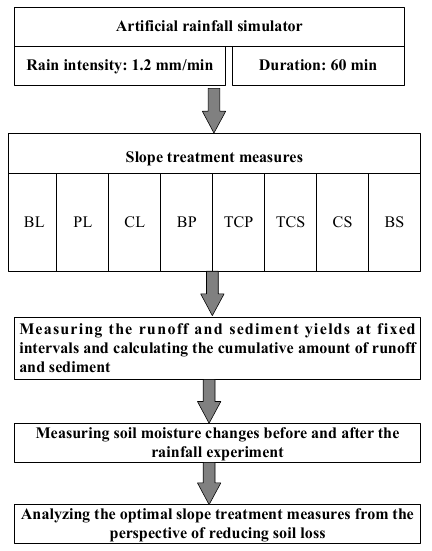
Figure 2. Flow chart of artificial rainfall experiments. The abbreviations in the figure denote different slope treatments, and the full name of each abbreviation is provided in Table 1.